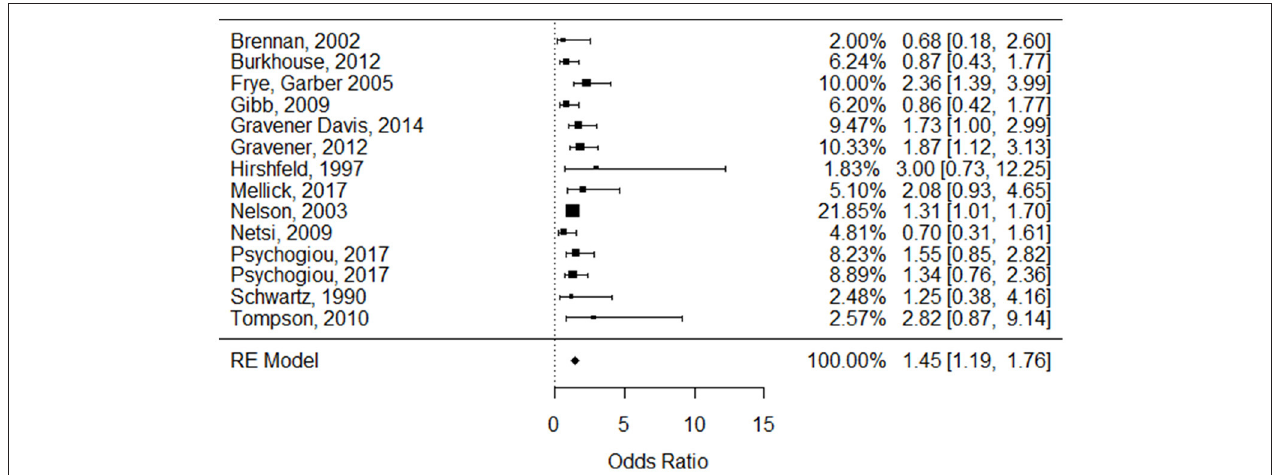
FIGURE 3 | Forest plot for the odds ratio based on the log scale of the association between parental psychopathology and high Expressed Emotion derived from 13 studies (based on 14 independent samples).